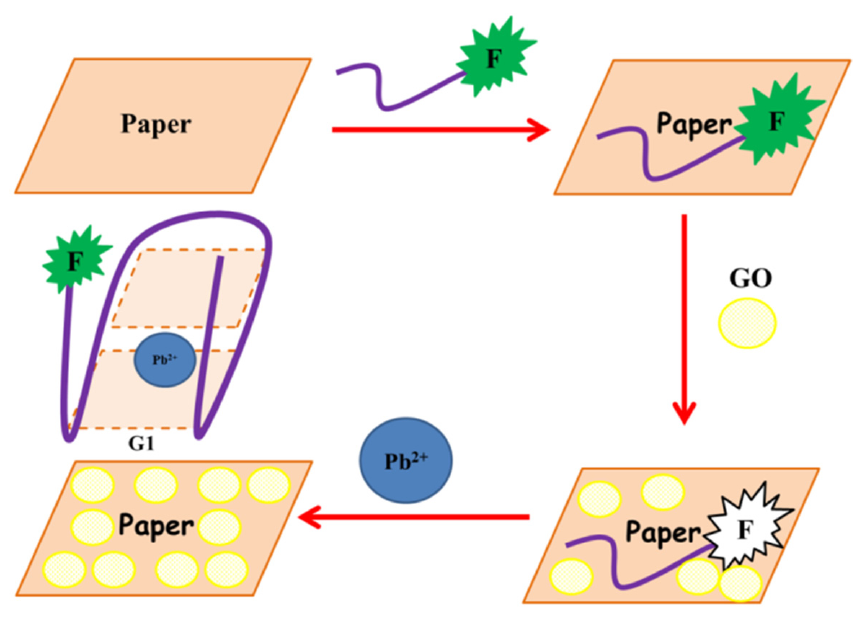
Figure 3. Schematic illustration of the preparation of G1 and its Pb 2+ ion sensing. Reprinted from [54] with permission from Elsevier.